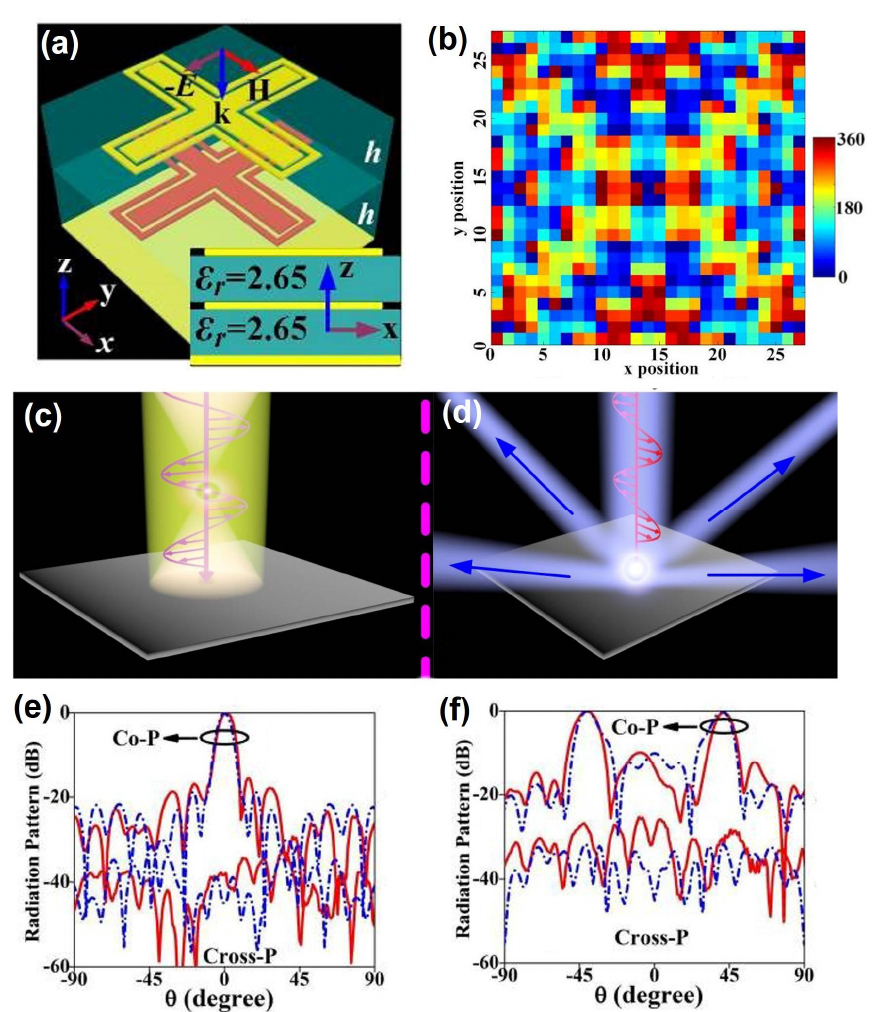
Figure 5. ( a ) Topology of the dual-layer anisotropic meta-atoms using composite cross bar and cross loop. The meta-atom contains two identical composite metallic resonators and a continuous metal plate (yellow) separated by two dielectric spacers (blue). ( b ) Phase distribution required on the metasurface to achieve quad-beam emissions. Schematics of a bifunctional metasurface which behaves as ( c ) a lens or ( d ) a beam splitter to generate quad large-angle pencil beams when excited by incident waves with polarizations E // x (yellow light) and E // y (blue light), respectively. ( e , f ) Simulated (red lines) and measured (blue dashed lines) radiation patterns on x - z plane for x polarization and y polarization, demonstrating the bi-functionality possessed by the fabricated device. Reproduced from [95] with permission.